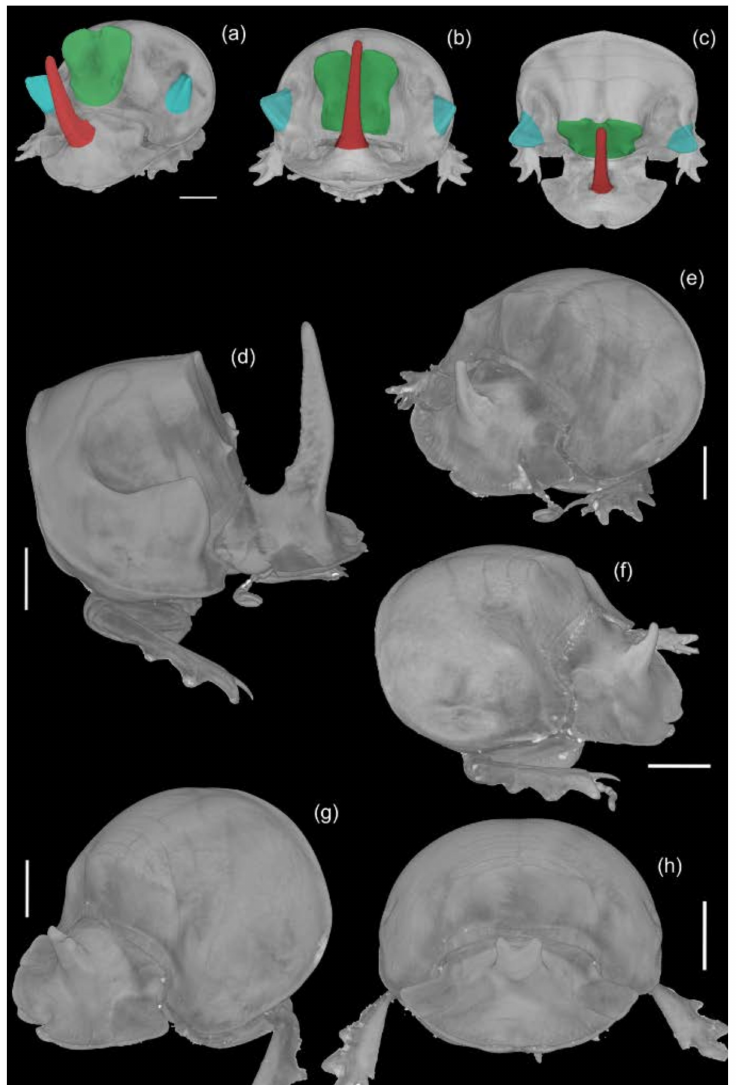
Figure 5. MicroCT images of the head and pronotum of the C. lunaris morphs. ( a ) Major male, with the various parts marked by colors: head horn (red), lateral pronotal prominences (blue), and pronotal horn (green); major male, the horn positioned above the median groove, ( b ) anterior view, and ( c ) dorsal view; ( d ) major male, with exaggerated development of the head and pronotum; ( e , f ) minor males, with different development of the pronotum; female, ( g ) side view, and ( h ) frontal view. Scalebars = 2